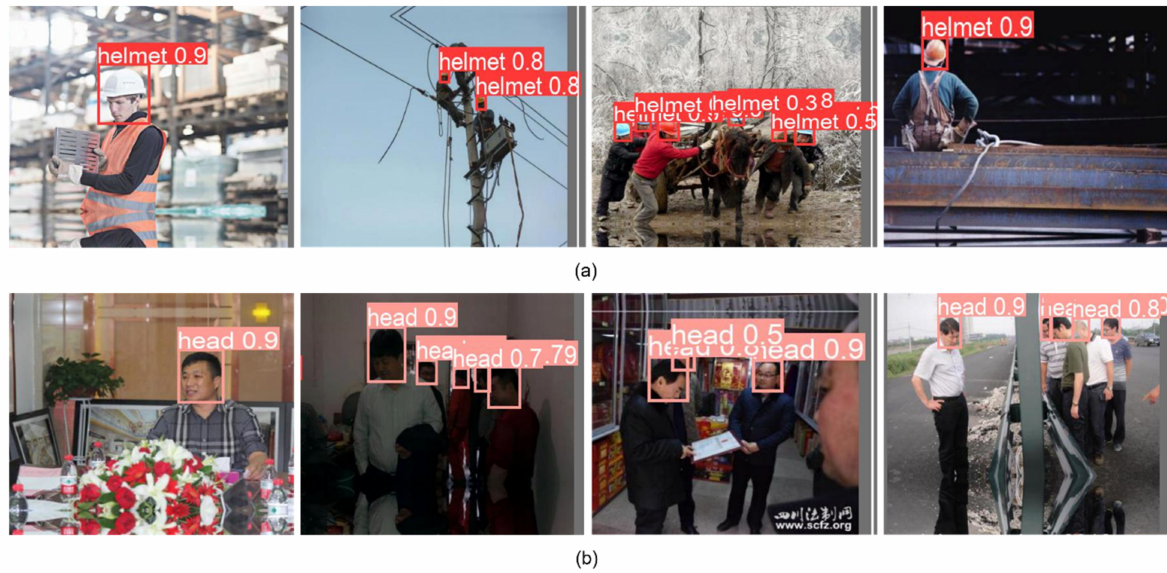
Figure 9. Prediction results of the YOLOv5x model. ( a ) Helmet class, ( b ) Head